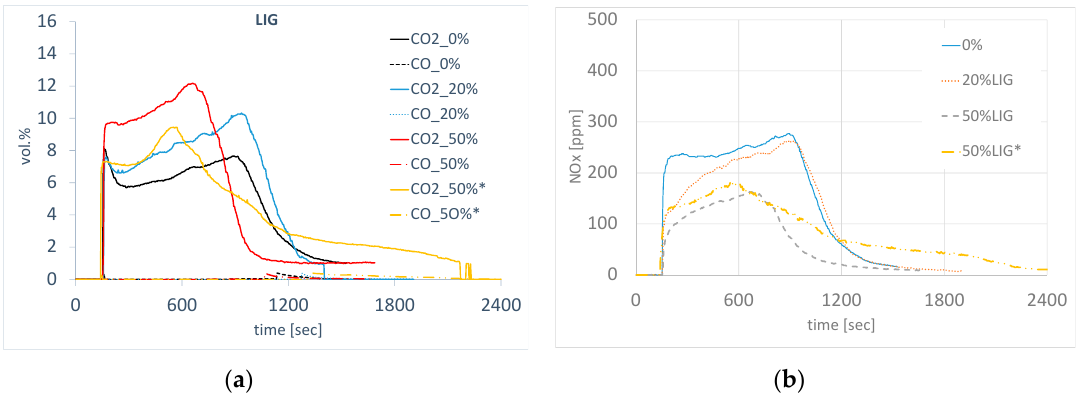
Figure 16. Concentration of CO, CO 2 , ( a ) and NO x ( b ) through the sintering with coke substitution. (* granulometry of Lig50c).